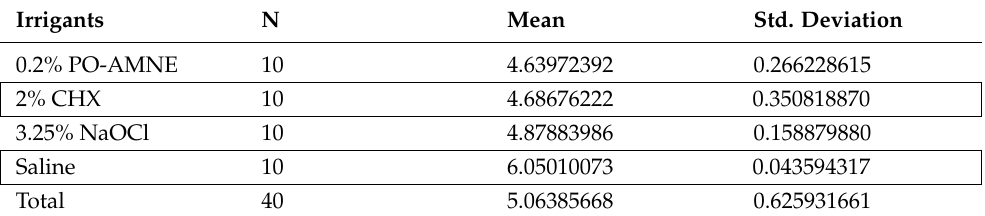
Table 7. Mean and standard deviation of irrigants against E. faecalis at 200 µ m.